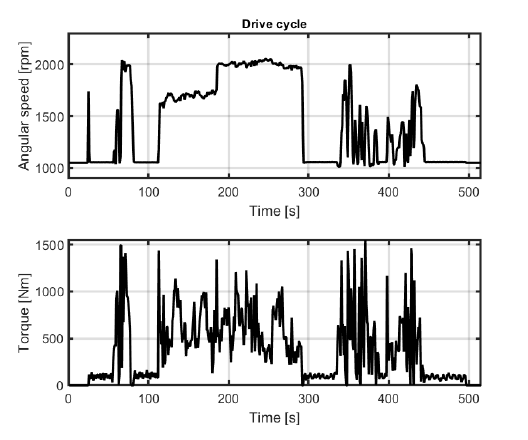
Figure 10: The load cycle of the backhoe